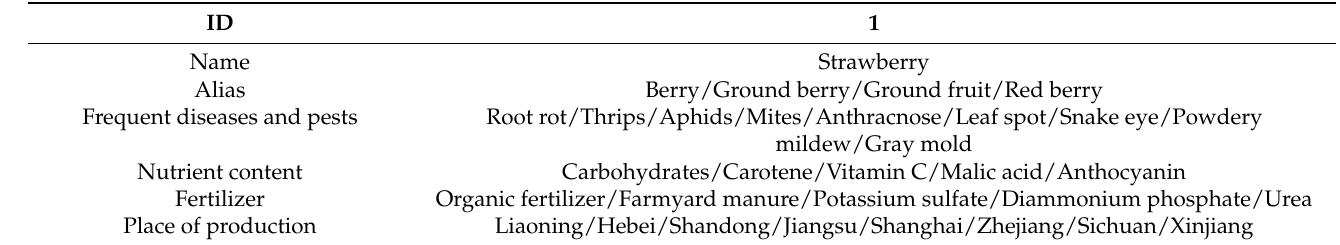
Table 3. Strawberry-related attribute recognition.